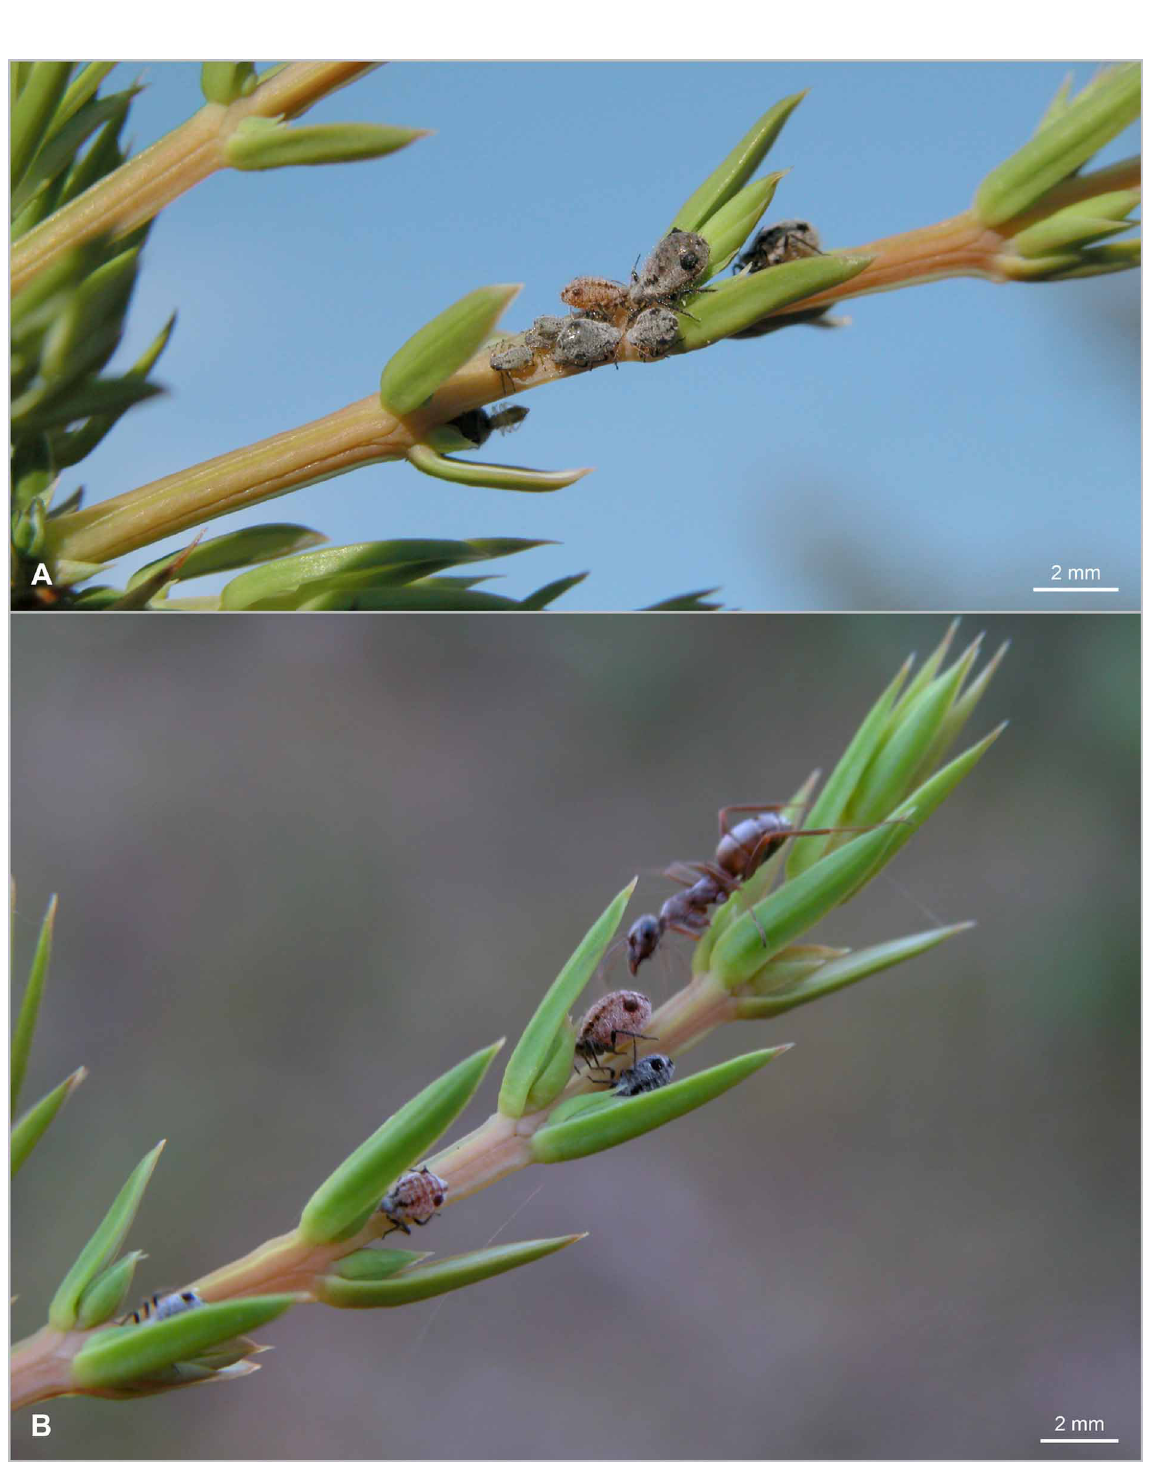
Fig. 113. Cinara (Cupressobium) juniperi (De Geer, 1773). Colonies on young shoots of Juniperus communis , in B attended by Formica cinerea Mayr,